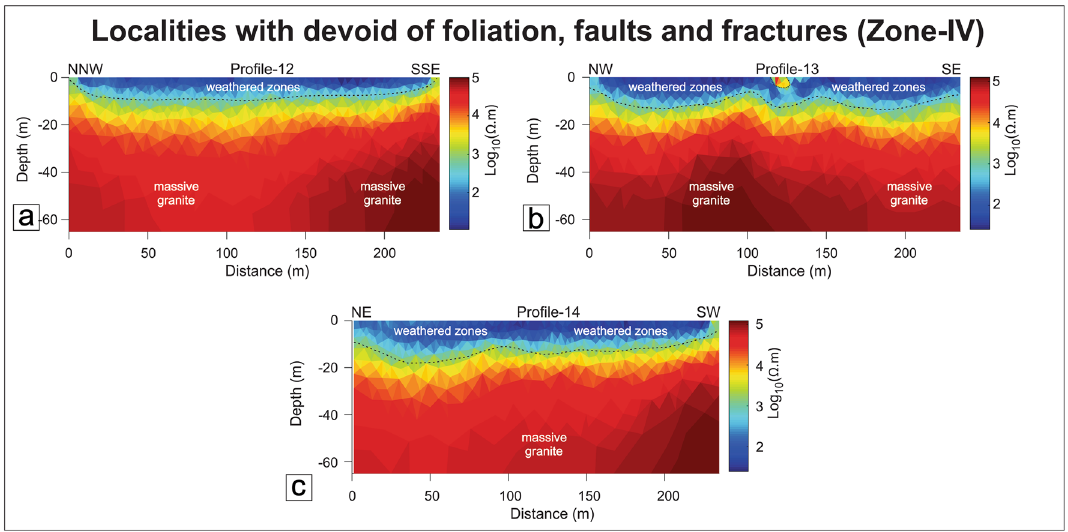
Figure 16. Resistivity profiles in Zone-IV. ( a ) Profile-12, Kansara area, ( b ) Profile-13, Surela area, ( c ) Profile-14, Padni (Fig. 13c) which shows similar features as P1 and P2 with an absence of any fractures in the resistivity section. In these localities, no such deep-seated weathered zones were found where water can be stored, although pervasive foliations are well present. Further, these subsurface features are in good agreement with the geological map. Zone-II: Localities with foliation, fractures, and faults (Brittle-Ductile zones). Four ERT traverses (P4: Kengora, P5: Ghoda, and P6–P7: Ajapur Mota) have been taken along/across the major shear zone areas with major/ minor faults and fractures. Profile-4 was collected using the gradient configuration in Kengora shear zone (KSZ) (SZ-I) (Fig. 1). The orientation of the resistivity profile is ENE-WSW, orthogonal to the KSZ. In this area, the G2 granites are highly mylonitized. The resistivity model shows three features namely, top weathered zone, deep fractured zone (sub-vertical), and massive granite/mafic granulite body (Fig. 14a). The resistivity model depicts a vertical to sub-vertical boundary of resistive and conductive zones at 400 m profile location. The boundaries show sub- vertical and in good pact with the regional geological map (Fig. 1), where a shear zone is likely in this position.